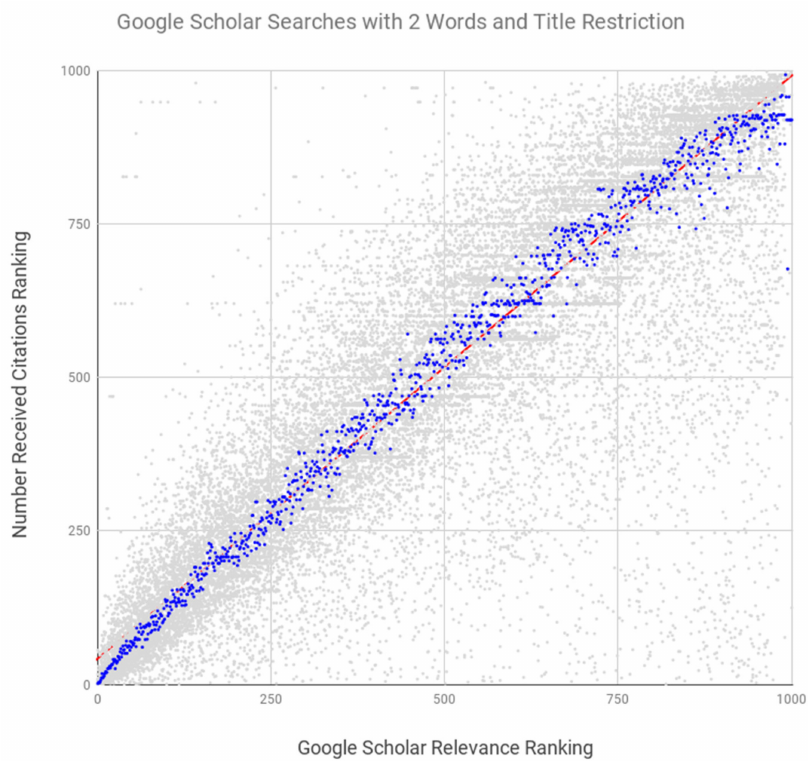
Figure 4. Google Scholar Searches with Two Words and Title Restriction (rho 0.994, median in blue, the rest of data in